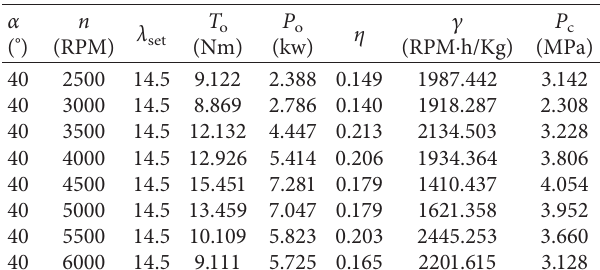
Table 3: Results of the GT-power simulation when α � 40 ° .